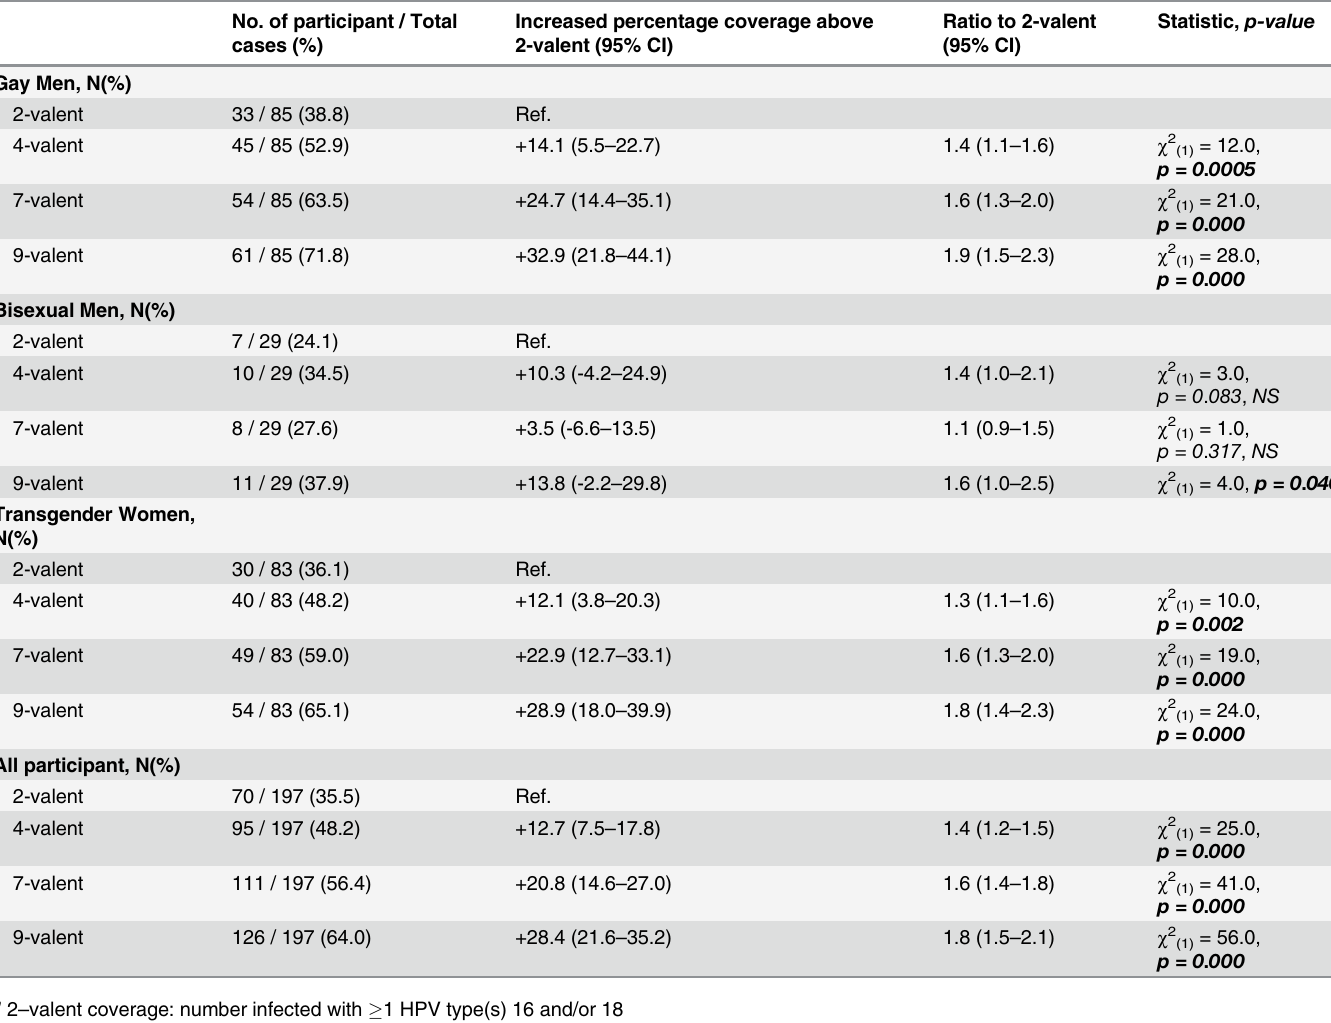
Table 4. Coverage by commercial a , b and investigational c , d HPV vaccines of (cid:1) 1 HPV infecting type(s), by gender identity of MSM subjects in Chiang Mai, Thailand, 2012 – 2013. No. of participant / Total cases